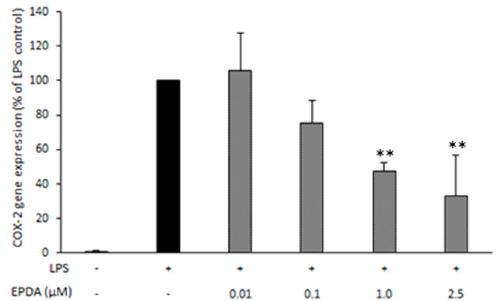
Figure 3. Effect of N -eicosapentaenoyl dopamine (EPDA) on cyclooxygenase-2 (COX-2) gene expression by RAW264.7 macrophages exposed to lipopolysaccharide (LPS). Cells were seeded in 6-well plates at 500000 cells mL -1 . After overnight incubation, cells were treated with (or without) LPS (0.5 µg mL − 1 ) and with (or without) EPDA (concentration range of 0.01–2.5 µM) for 24 h. Each sample was normalized on its RPS27A2 mRNA content. Data are expressed as percentages of LPS control (black bar, set at 100%), and represent the mean of three independent experiments (each done in duplicate) ± S.D. Asterisks indicate different mean values from those of control (** p < 0.01).